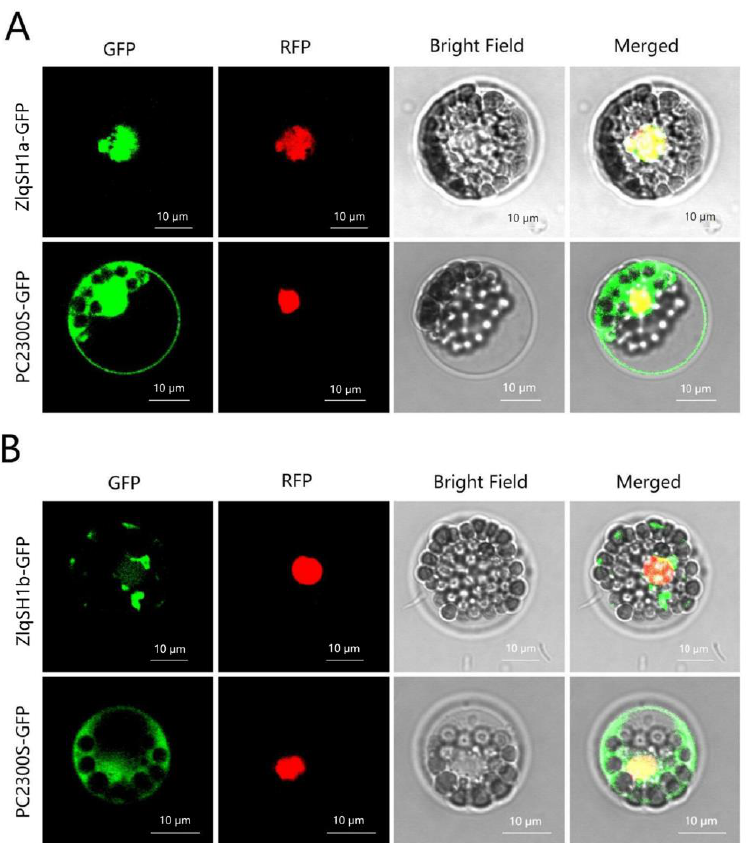
Figure 4. Subcellular localisation of the ZlqSH1a and ZlqSH1b proteins. ( A ) ZlqSH1a- GFP and PC2300S-GFP; ( B ) ZlqSH1a- GFP and PC2300S-GFP. GFP: green fluorescence (protein of interest); RFP: red fluorescence (nucleus); Bright: open field channel; Merged: fluorescence integration. Bar: 10 μm.